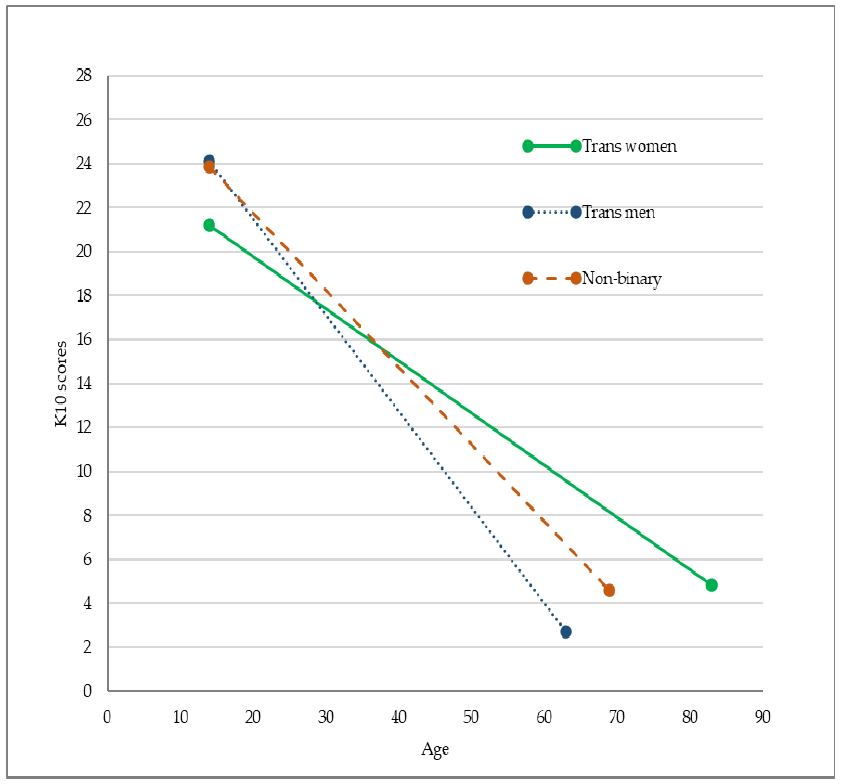
Figure 3. The interaction effect of age and gender on K10 psychological distress scores.